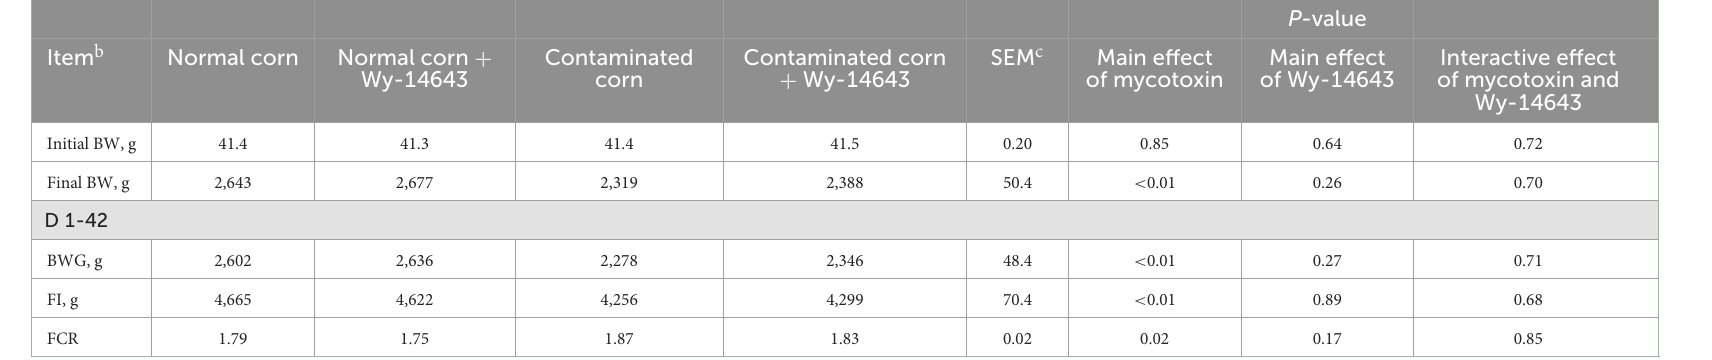
TABLE 4 Effects of PPAR- α agonist on growth performance in broilers fed mycotoxin contaminated corn a .